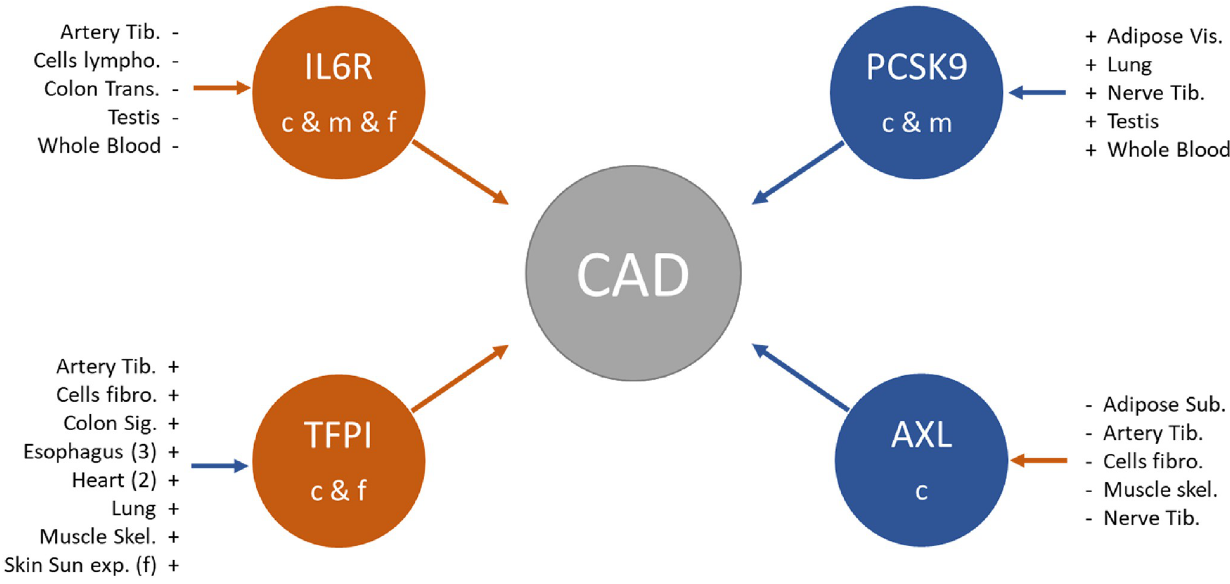
Fig 4. Graphical overview of causal networks form gene expression (GE) over protein expression (PE) on the outcome coronary artery disease (CAD). Orange arrows indicate a negative causal effect of protein level on CAD (IL6R and TFPI) or of gene expression on protein levels, blue arrows denote positive links. The settings are indicated by c (combined), m (males) and f (females). Tissues in which gene expression showed a significant indirect effect on CAD are listed next to their gene. Bold tissues indicate also a significant direct